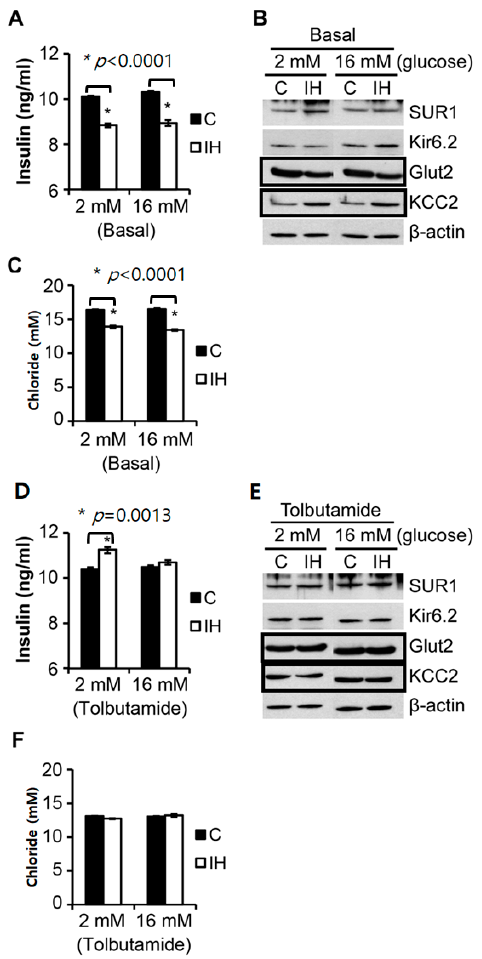
Figure 3. Comparisons of control vs. intermittent hypoxia (IH)-treated islets in the quantity of insulin secretion and the chloride levels measured from isolated primary islets at different glucose levels. IH treatment was performed 12 h prior to this set of assays. Insulin secretion quantified by Enzyme-linked immunosorbent assay (ELISA) ( A ), KCC2 levels compared using Western blots ( B ) and chloride content quantified by a colorimetric assay ( C ) following IH exposure in 2 mM and 16 mM glucose media. No influence from the different glucose levels in media was noted. Western blots for Glucose transporter 2 (Glut2) and KCC2 show a marked difference between the control and IH in both glucose media. Levels of sulfonylurea receptor 1 (Sur1) and ATP-sensitive K + channel (Kir6.2) showed no marked changes. Addition of tolbutamide to 2 mM increased insulin secretion ( D ). Western blots showed minimal changes in response to tolbutamide (E) and the chloride levels showed no changes (F). Full-length blots are found in the Supplementary Information, Figure S1. * indicates significantly